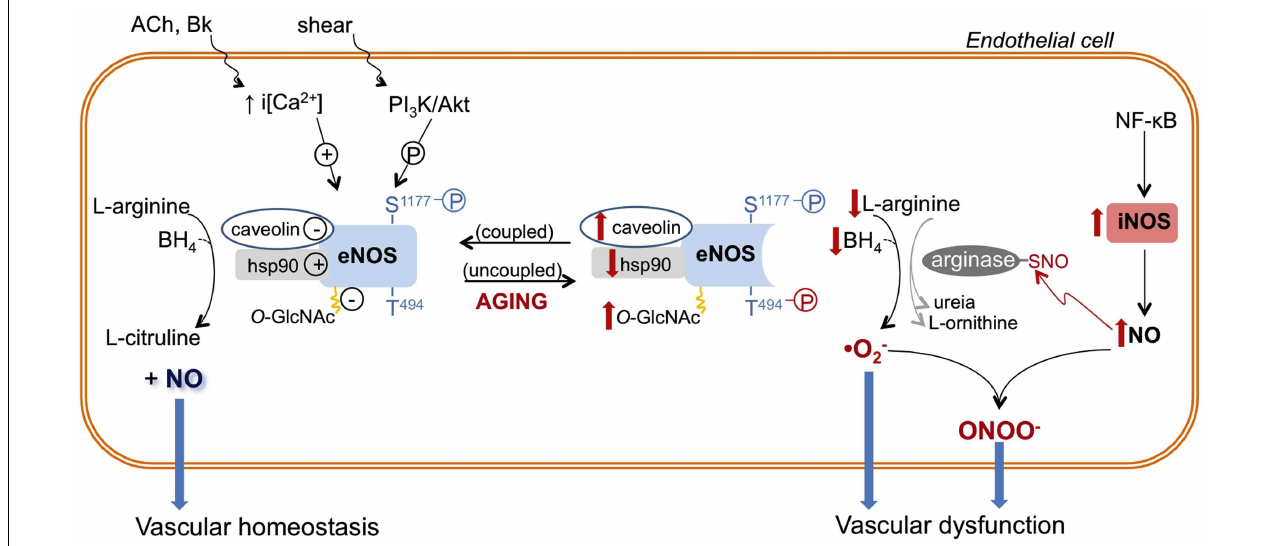
FIGURE 1 | Role of nitric oxide synthase (NOS) enzymes in endothelial function and aging-associated endothelial dysfunction. Endothelial (e)-NOS isoform converts l-arginine to nitric oxide (NO). eNOS activity is determined by intracellular calcium concentration [i(Ca 2 + )] and/or its phosphorylation (P) state at different sites (e.g., eNOS is positively and negatively modulated by phosphorylation of serine 1177 (S 1177 ) and threonine 494 (T 494 ), respectively). In addition, eNOS activity is inhibited by its interaction with caveolin-1 and by O -GlcNAc modification, while eNOS association with heat shock protein 90 (hsp90) favors its activation. In endothelial aging, NO synthesis is compromised because eNOS activity is decreased due to increased expression and interaction with caveolin, reduced expression and association with hsp90, reduced phosphorylation of S 1177 and